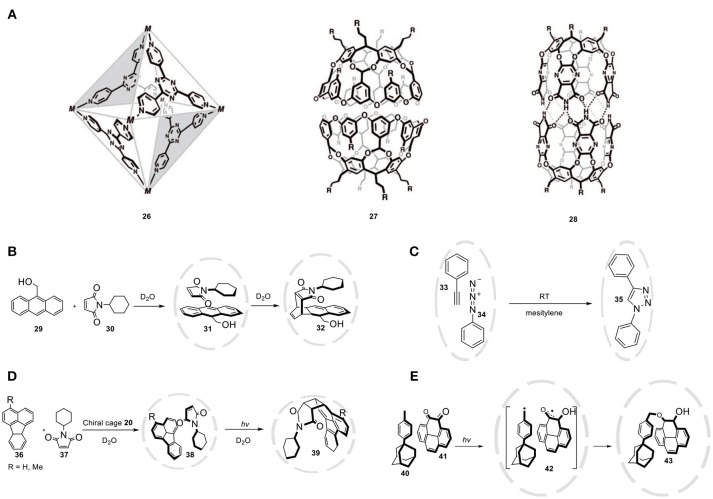
(A) Capsules based on non-covalent interactions. (B) Diels-Alder reaction between 29 and 30 in the cavity of host 26, yielding unusual regioisomer 32. (C) A regioselective 1,3-dipolar cycloaddition accelerated within nanoreactor 28. (D) Asymmetric [2+2] photodimerization of fluoranthenes (36) and N-cyclohexylmaleimide (37) within a chiral analog of cage 26. (E) Regio- and stereoselective bimolecular radical coupling within cage 26.